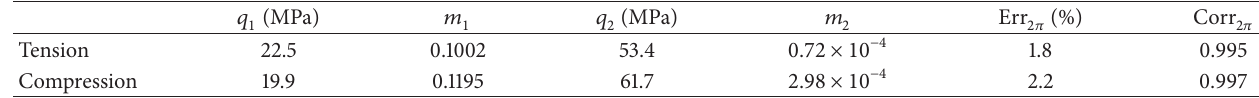
Table 1: Material constants, error, and correlation of the two-term power-law equation.